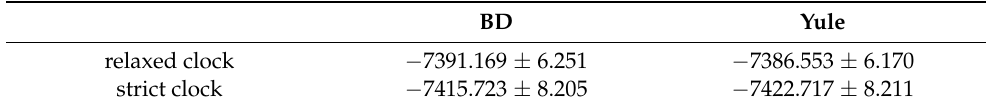
Table 3. Marginal likelihoods estimated using the nested sampling approach under relaxed and strict clock models in combination with Birth-Death (BD) and Yule speciation